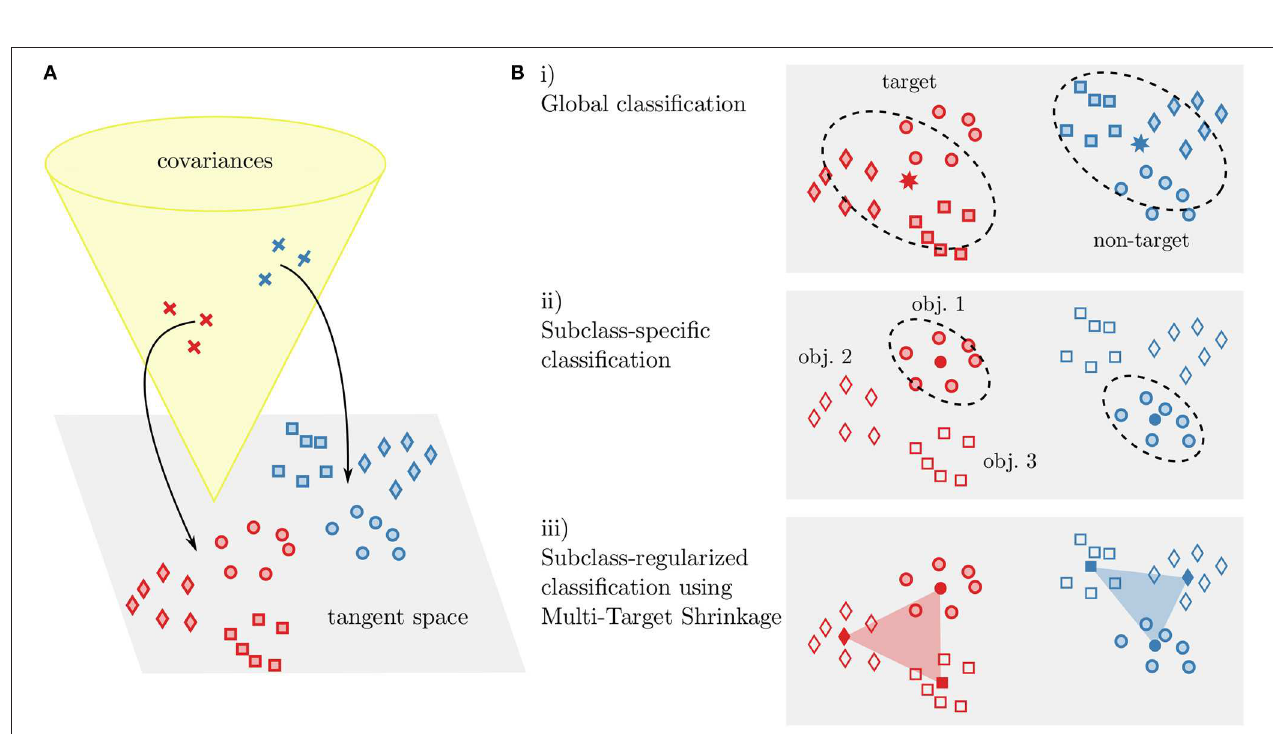
FIGURE 4 | Illustration of our covariance-based classification approaches. Covariances C k ⊂ S ++ are projected into the Riemannian tangent space T | C m (A) . In the tangent space, classification is performed using linear discriminant analysis (B) . Either a single classifier is trained on the data (i, corresponding to TS+LDA ), separate classifiers are trained for each subclass (ii, sep. TS+LDA ), or the class means of subclass-specific classifiers are regularized toward other subclasses (iii, cTS+reg-LDA ). This can be seen as a weighted inclusion of data from other subclasses. Note that for the latter case, we also perform centering by parallel transport of the members of each subclass in covariance space. In the figure, classes (target and non-targets) are indicated by color and subclasses (object instances) by different markers.